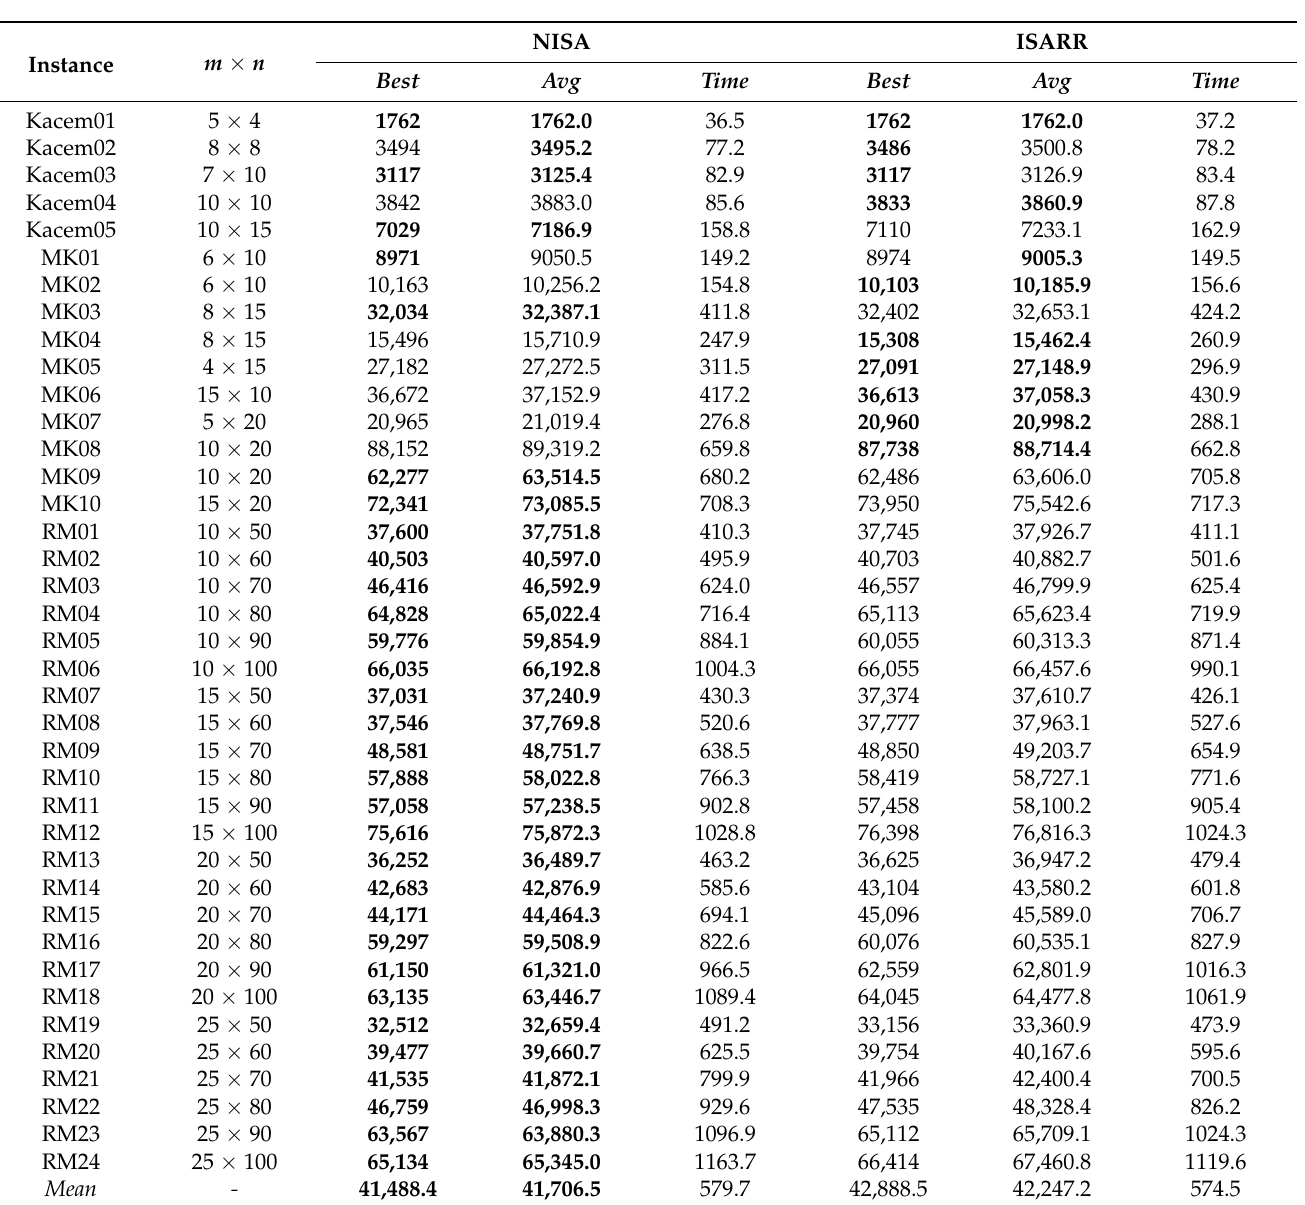
Table 4. Effectiveness analysis of the population initialization